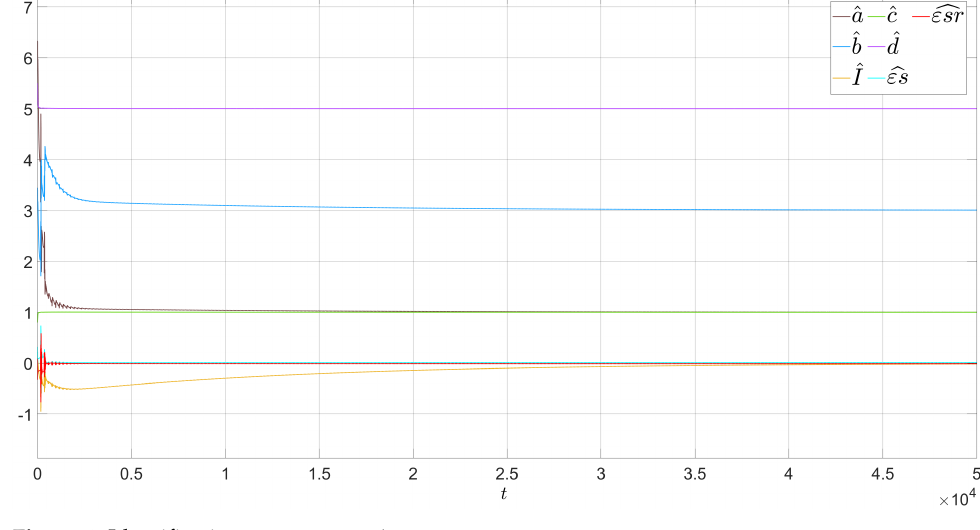
Figure 4. Identification process, γ = 1.